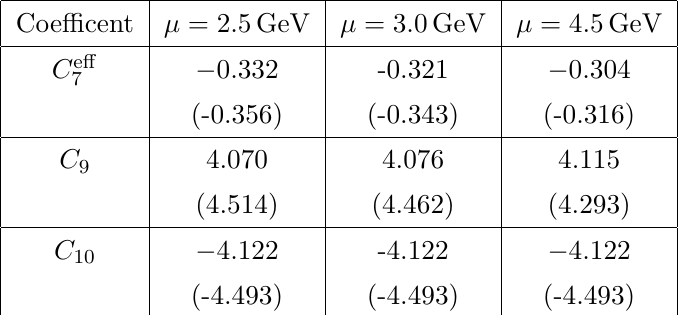
in the LCSRs for the soft-gluon emission contributions. They are displayed in table 1.